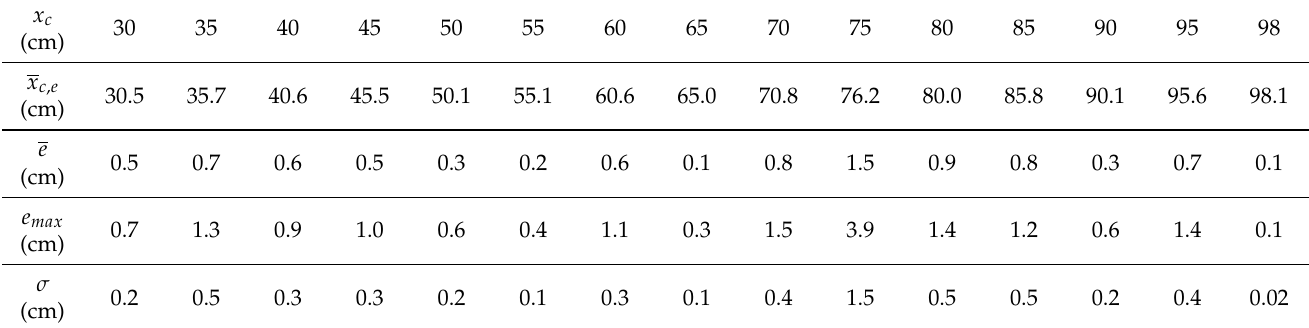
Table 3. Experimental results obtained for the estimation of the contact point for Case 1.